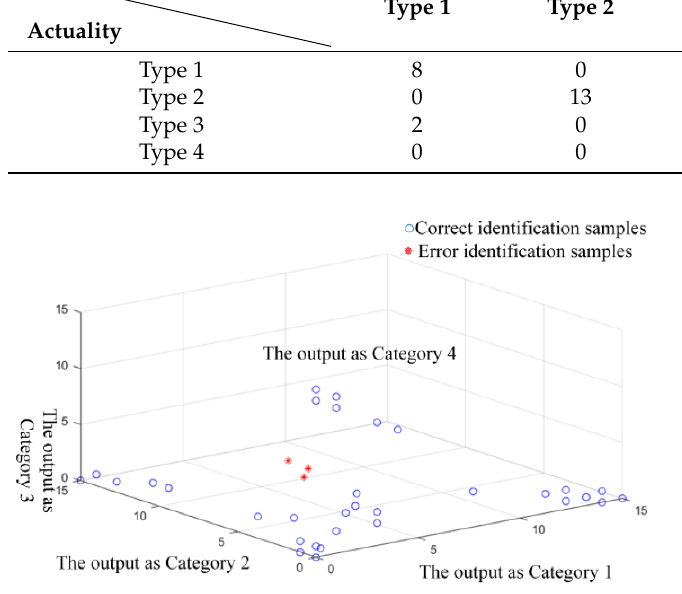
Figure 6. Performance of random forest classifier.